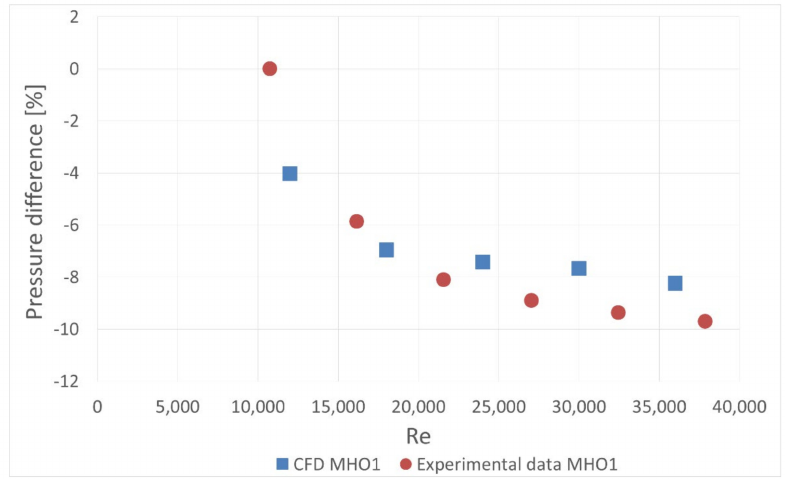
Figure 25. Pressure drop di ff erence for the case with disturbed flow. Validation of the numerical